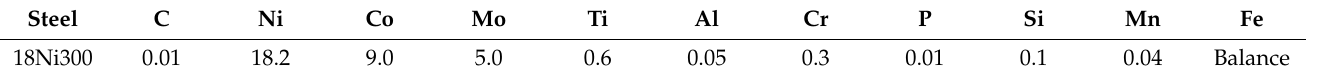
Table 1. Chemical composition of the material (wt.%).